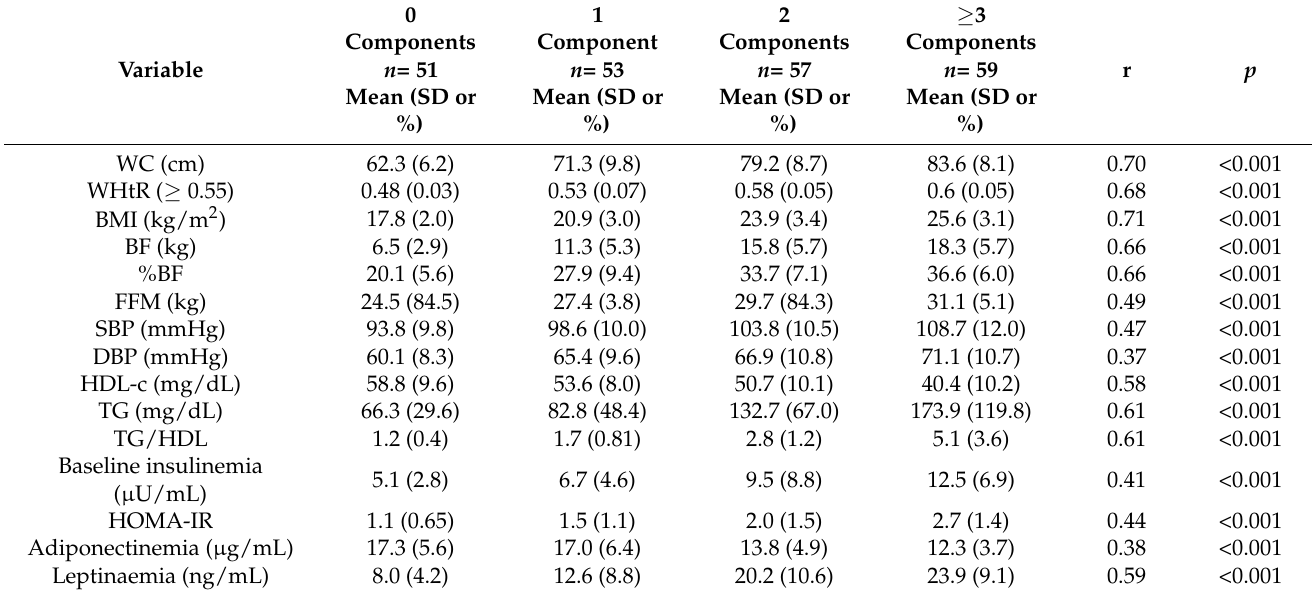
Table 2. MetS components and linear trend analysis for independent variables.